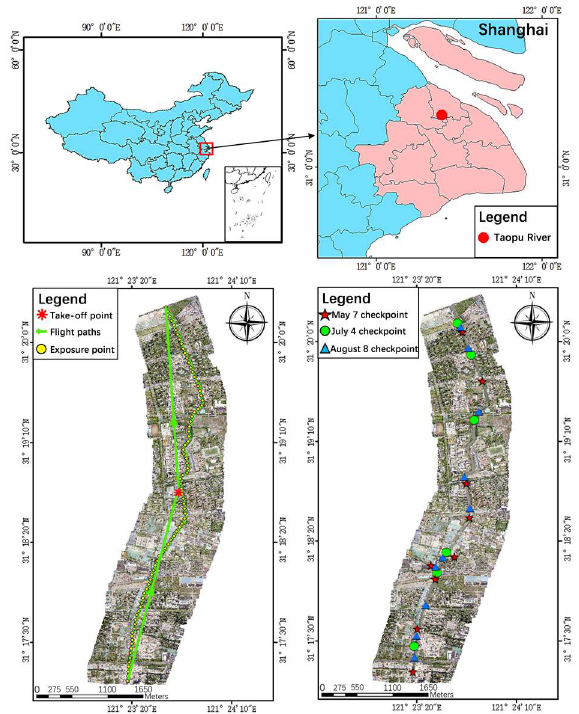
Figure 3. Study site, flight paths and checkpoints of Taopu River water quality monitoring